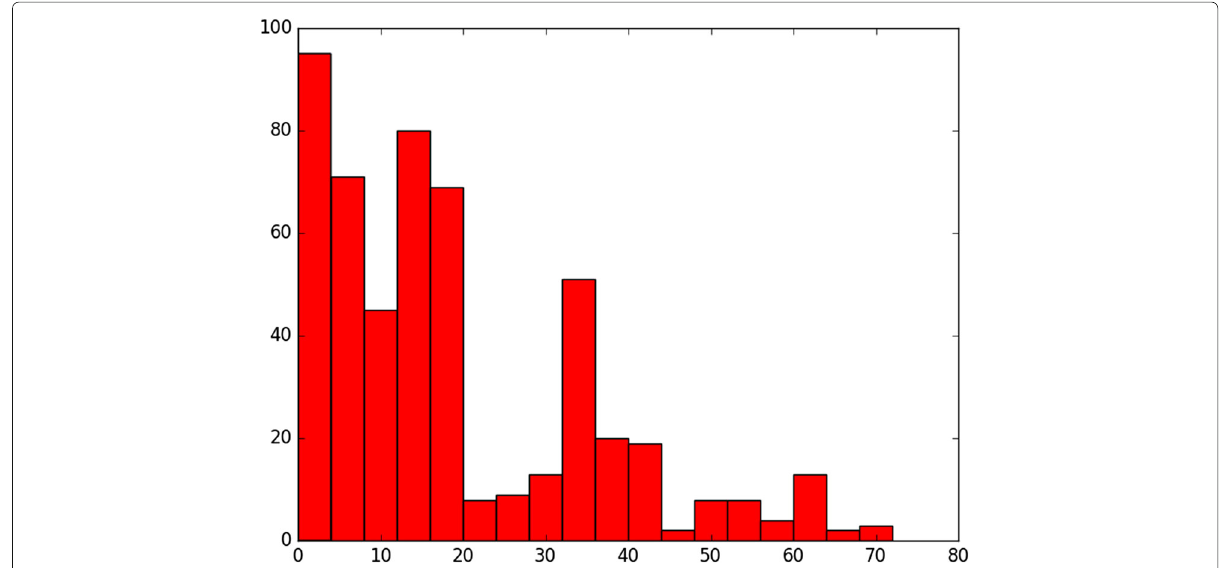
Fig. 6 SOS Calls made by user. Number of calls made by users manually. At the beginning, users were testing the system a lot to see how it works and whether someone will answer. Later, manual calls dwindle and more closely represent actual